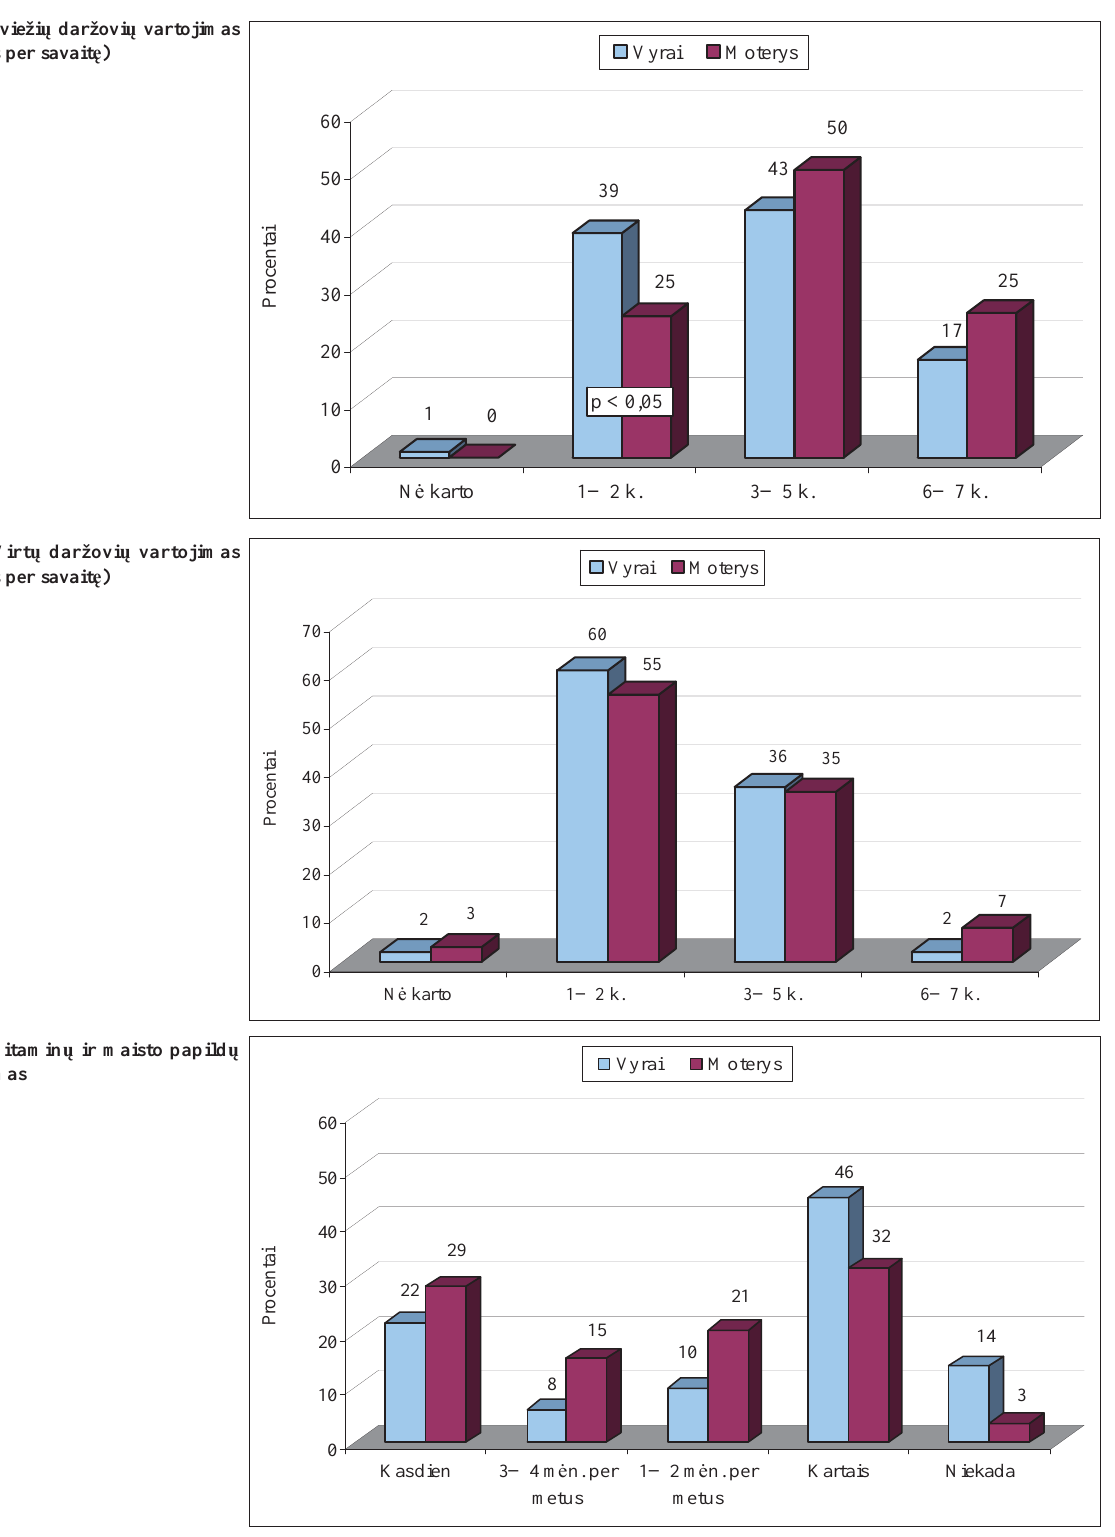
3—5 kartus per savait ę šviežias daržoves vartoja daugiau moter ų (50%), nei vyr ų (43%). Niekada nevartoja švieži ų daržovi ų 1% tirt ų k ū no kult ū ros mokytoj ų vyr ų . Didžioji dauguma tirt ų k ū no kult ū ros mokytoj ų šviežias daržoves valgo 2—5 kartus per savait ę (2